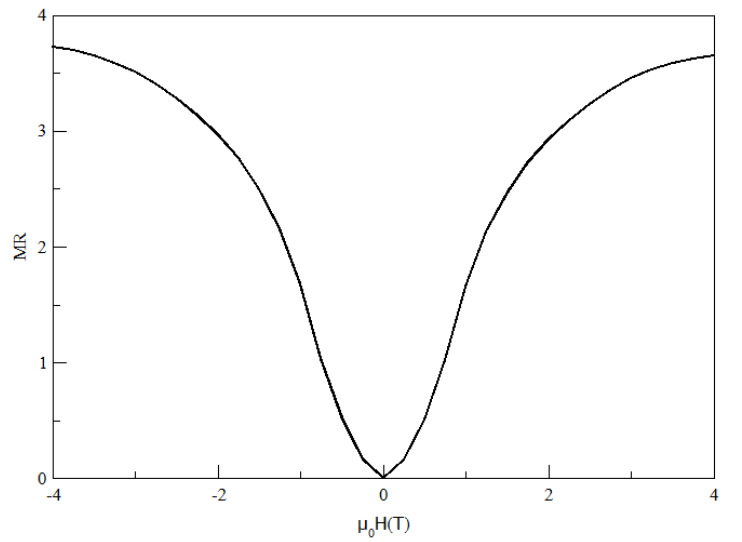
Figure 4. Relationship between the applied perpendicular magnetic field and the magnetoresis- tance